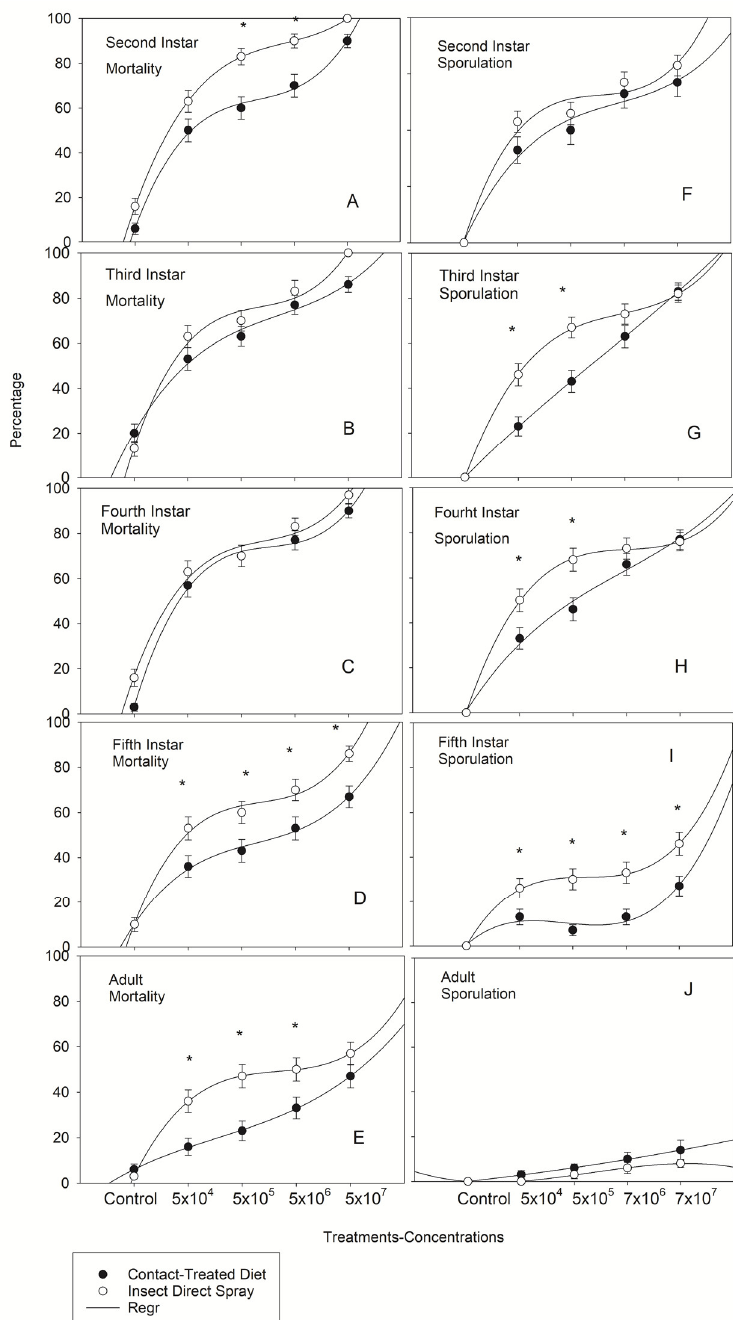
Figure 4. Regression (GLM) (Quadratic Trend Model) analysis predicting the probability of mortality percentage ( A – E ) of Nezara viridula nymphs ( A – D ) and adults ( E ) and sporulation percentage ( F – J ) of Beauveria bassiana as a function of dose level by contact and direct spray. (*) indicates that mortality and sporulation in Insect Direct Spray was significantly higher than Contact-Treated diet (Tukey’s HSD test, p = 0.05).